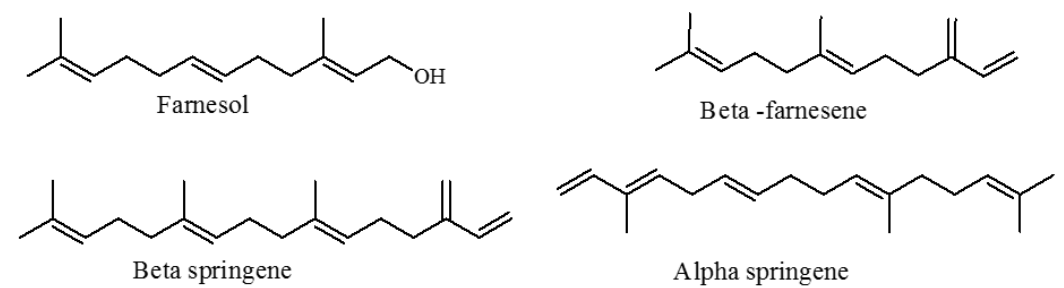
Figure 5. Compounds of chemotaxonomic significance identified from T. vogelii.